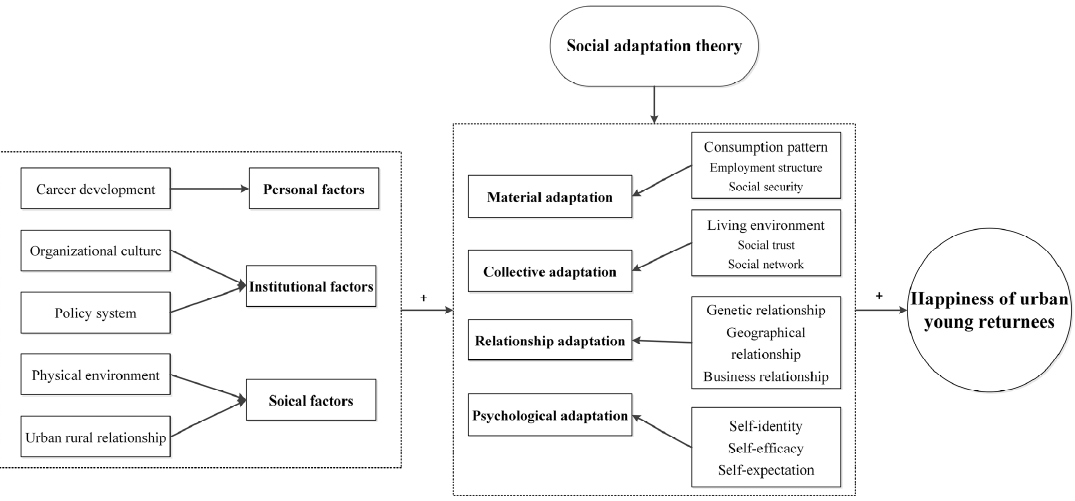
Figure 1. The theoretical framework of the study. Source: Authors.